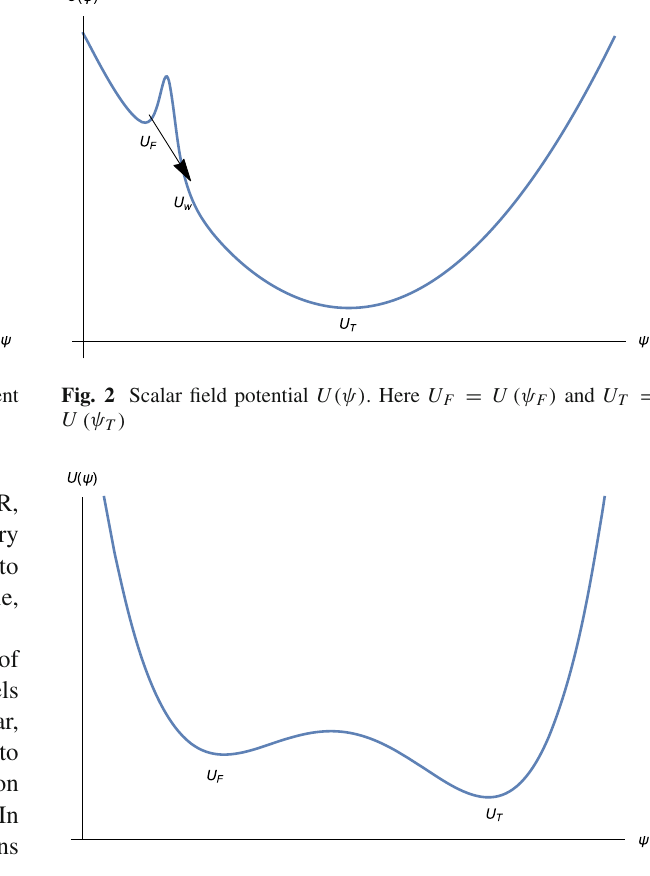
Fig. 3 Potential with a false and true